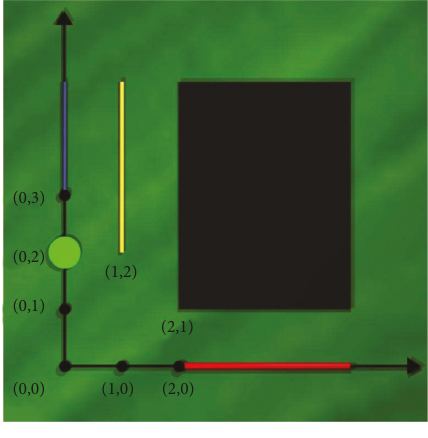
Figure 2: Decomposition D